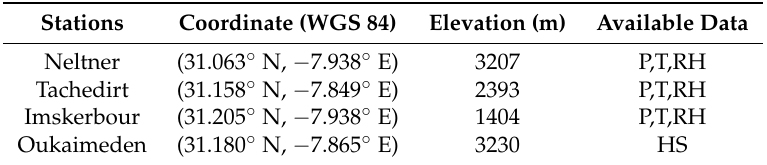
Table 2. Description of the three automatic weather stations (T: temperature, P: precipitation, RH: relative humidity, HS: height of